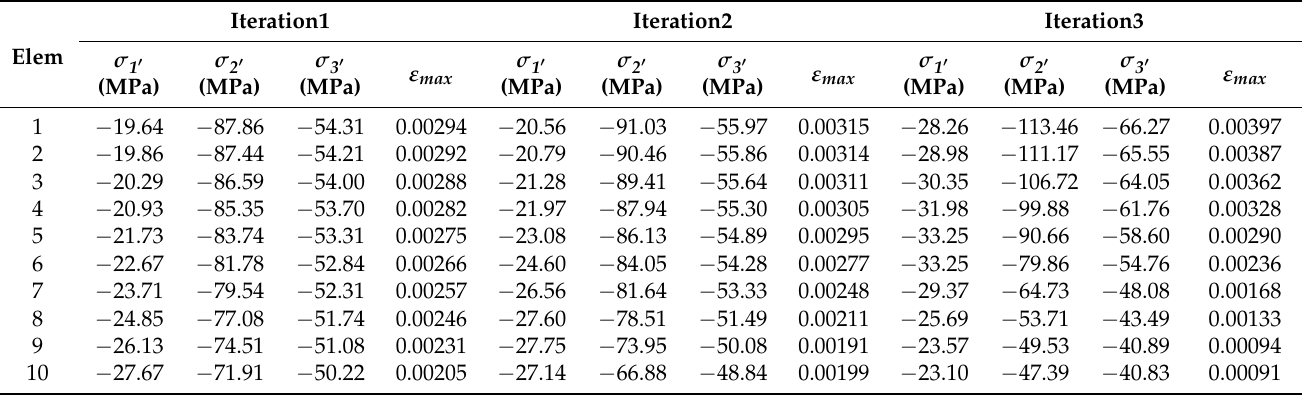
Table 3. Data of effective principal stresses and breakout region in the process of